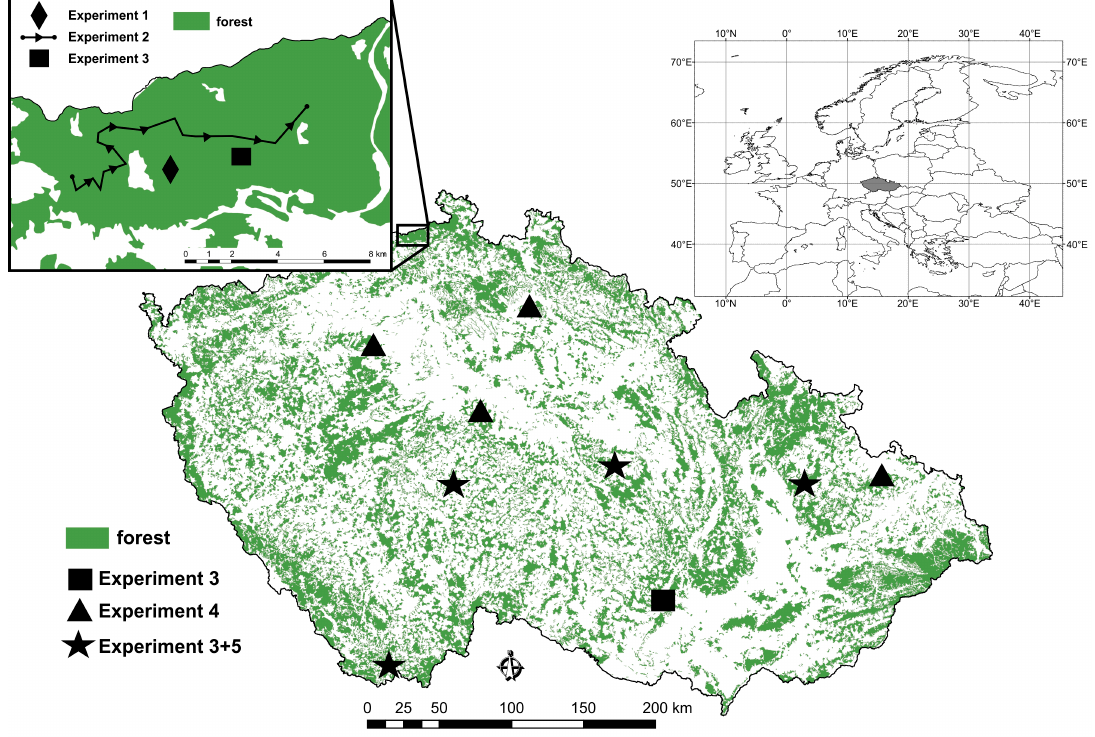
Figure 1. Study sites in the Czech Republic where experiments 1–5 were conducted from 2014 to 2019. As indicated, most experiments were conducted at more than one site, and two experiments were sometimes conducted at the same